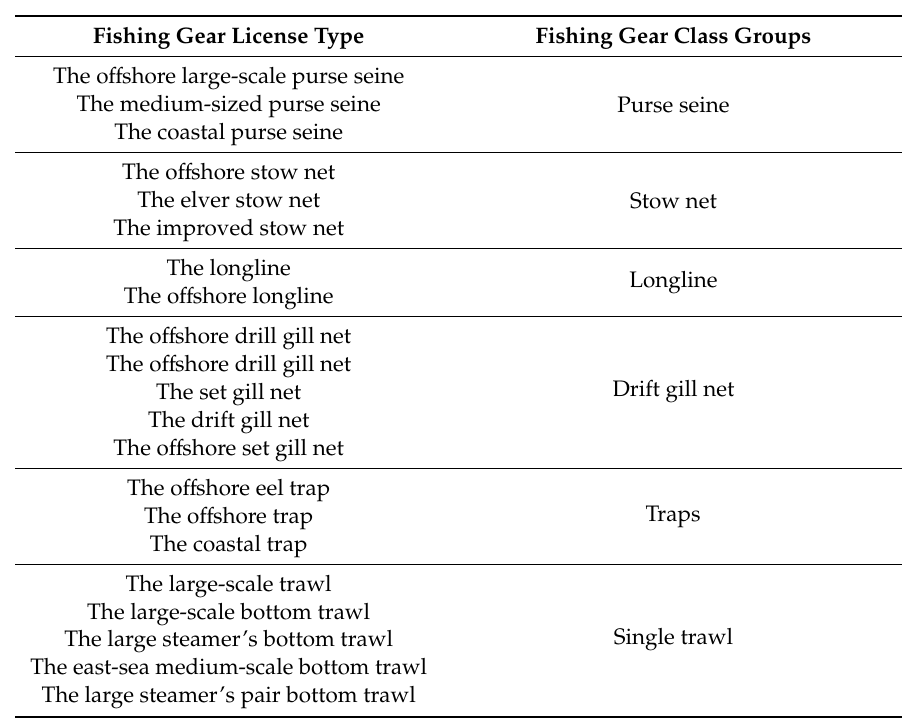
Table 3. Fishing gear